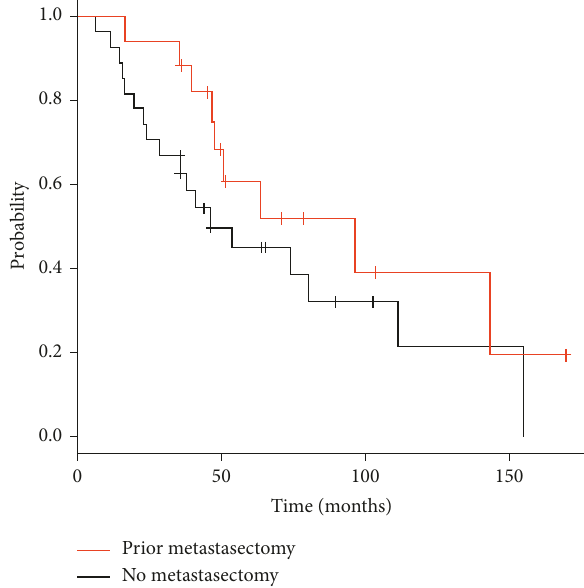
Figure 3: Actuarial overall survival from diagnosis in patients with and without a history of